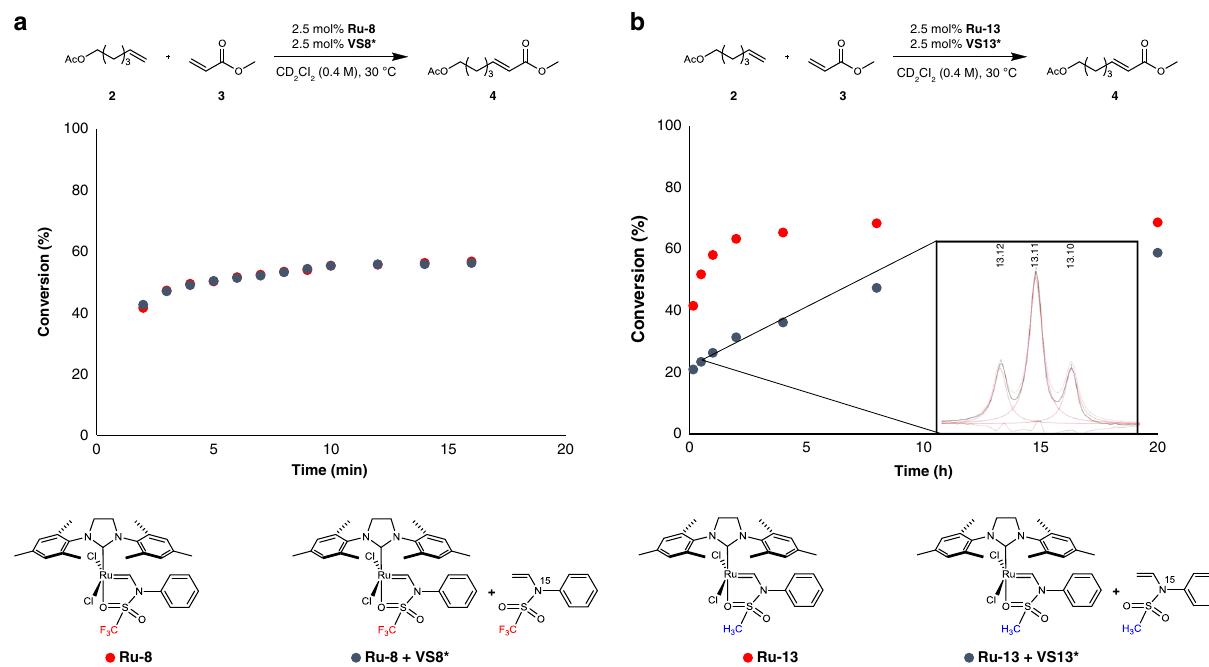
Fig. 3 Effect of the external N -vinylsulfonamide ligand. a No difference in reactivity of Ru-8 was observed regardless of the presence of 15 N-labeled external VS8* . b The catalyst with the electron-donating group on the sulfonyl moiety exhibited a diminished reaction rate in the presence of 15 N-labeled external VS13* . The carbene ’ s proton peak of Ru-13 in 1 H NMR spectra indicated the occurrence of ligand exchange (54:46 ratio of Ru-13 (13.11 ppm, singlet) to Ru- 13* (doublet)) from the initial stage of the reaction